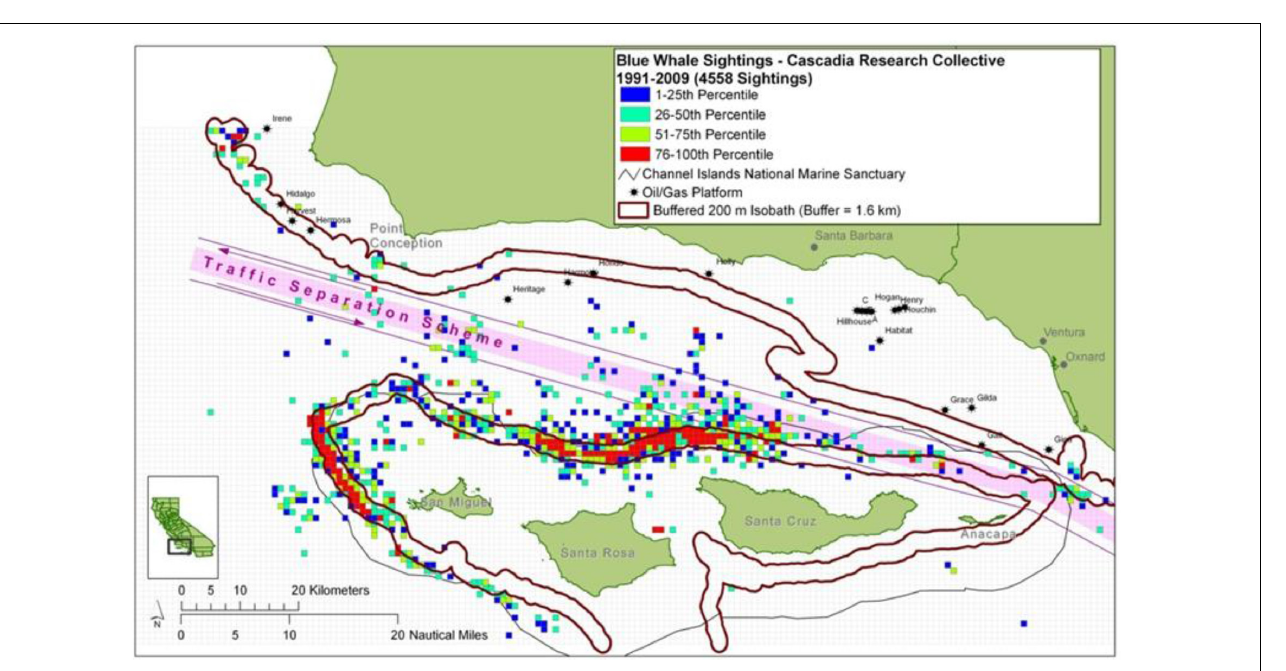
FIGURE 5 | Blue whale daytime sighting locations from Cascadia Research non-systematic surveys 1991–2009 when high densities were seen in the Santa Barbara Channel showing high density of occurrence around 200 m isobaths and mostly south of the designated shipping lanes at that